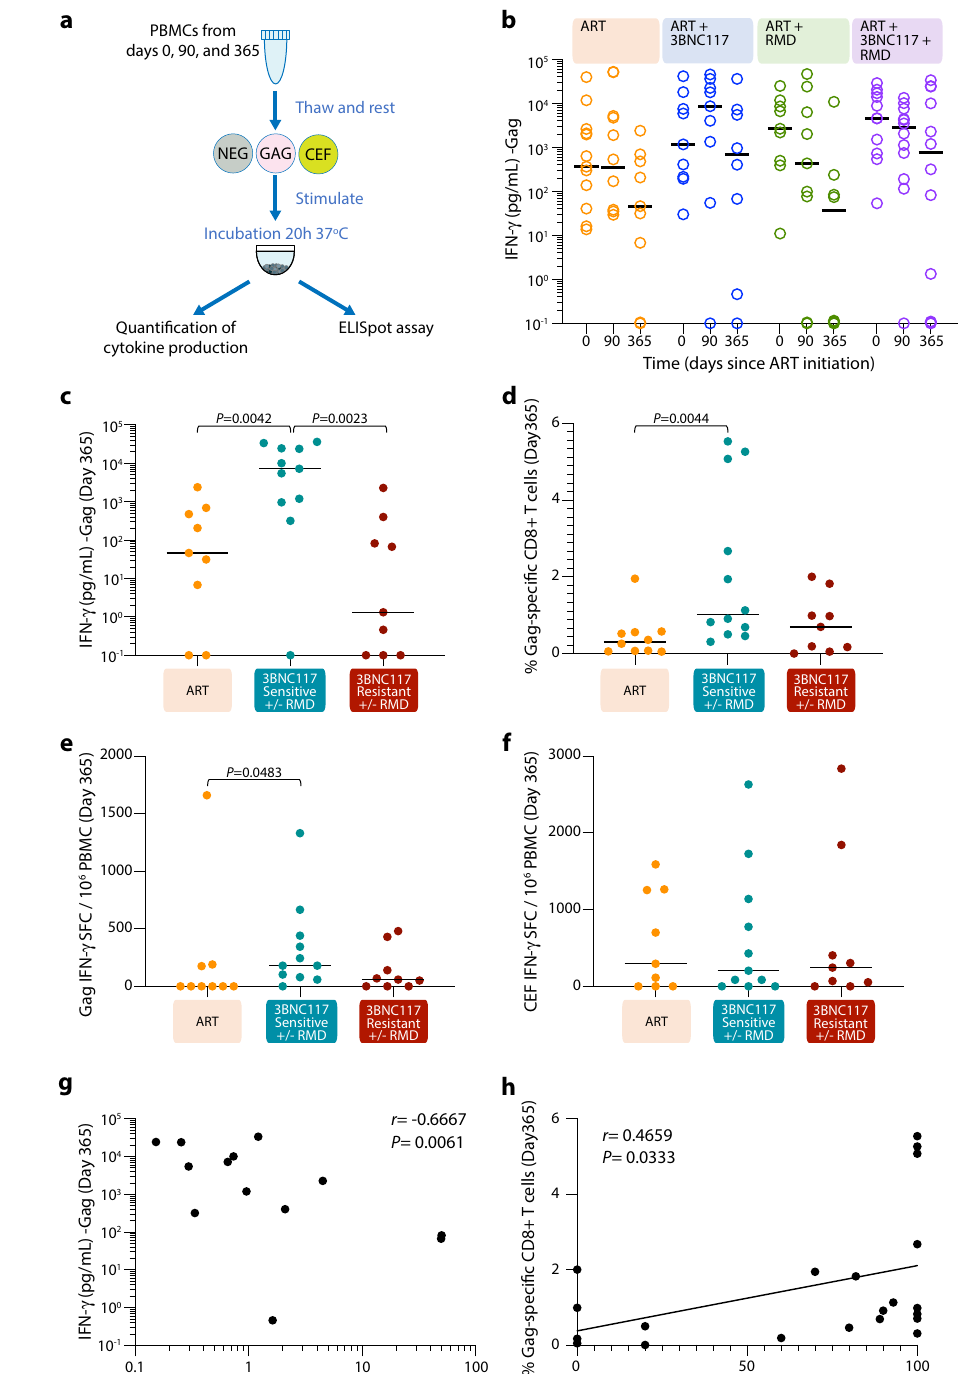
Fig.3|DetectionofIFN- γ andcorrelationbetweenTcellimmunityandpre-ART sensitivity to 3BNC117. a Representation of the protocol followed to detect interferon-gamma (IFN- γ ) release and ELISpot upon Gag stimulation. b Concentration of IFN- γ (pg/mL) in the supernatants from HIV-1 Gag stimu- lated PBMCs detected by Mesoscale for each randomization group ( n = 13 ART-control group, n =9 in ART+ 3BNC117, n =9 in ART+ RMD and n = 12 in ART+ RMD + 3BNC117). Concentration of IFN- γ (pg/mL) in the supernatants ( n = 29) ( c ), frequency of speci fi c-CD8 + T cells ( n = 31) from HIV-1 Gag stimu- lated PBMCs ( d ) and IFN- γ ELISpot response to Gag ( n = 29) ( e ) and to CEF (CMV, EBV and in fl uenza virus) ( n = 29) ( f ) at 365days after ART initiation is